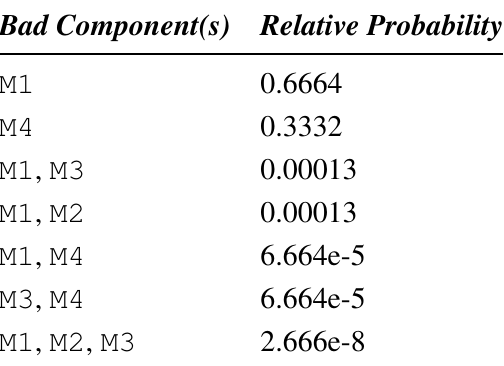
Table 2. Seven alternative diagnoses of faults in the circuit shown in Figure 25, derived from multiple alignments created by the SP model with “ TM1I1 TM1I2 TM2I1 TM2I2 TM3I1 TM3I2 FM4O TM5O ” in New and the patterns from Figure 27 in Old. The relative probability of each diagnosis is shown in the second